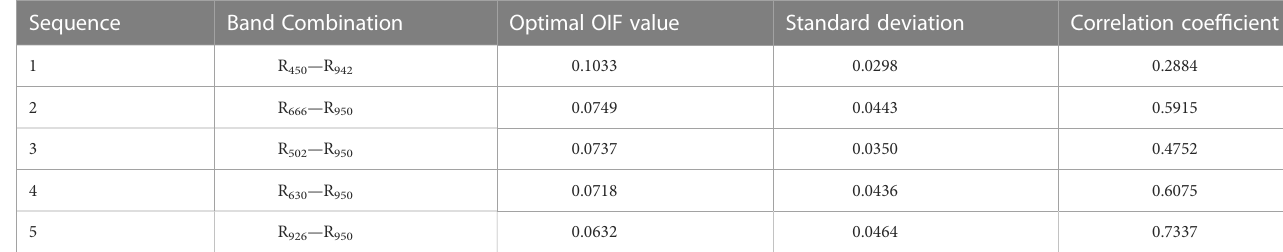
TABLE 3 Band combinations obtained from OIF (n=24).